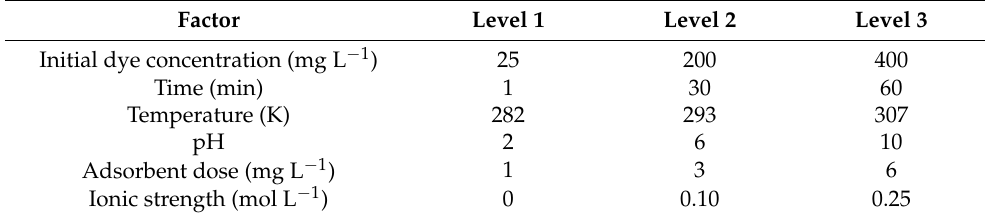
Table 5. Controllable factors and their levels, used in the Taguchi design.